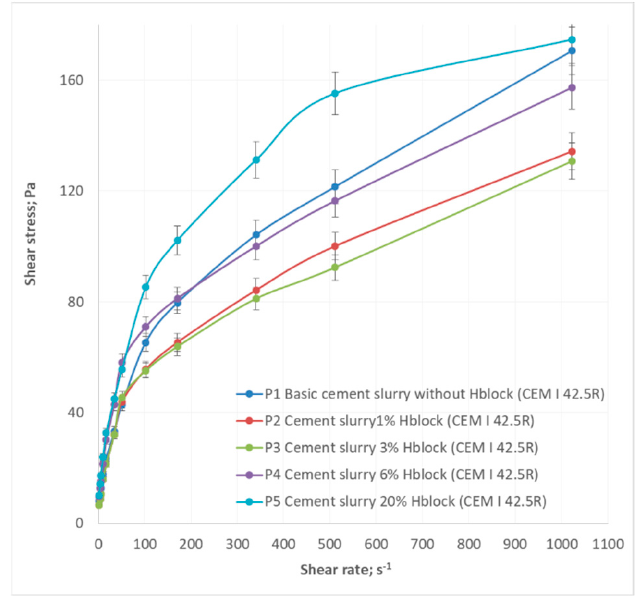
Figure 18. Flow curves for cement slurries with the addition of Hblock (cement class CEM I 42.5R). A different course of the flow curves takes place during the interpretation of slurries with the addition of the Hblock agent prepared on the basis of drilling cement G (Figure 19).